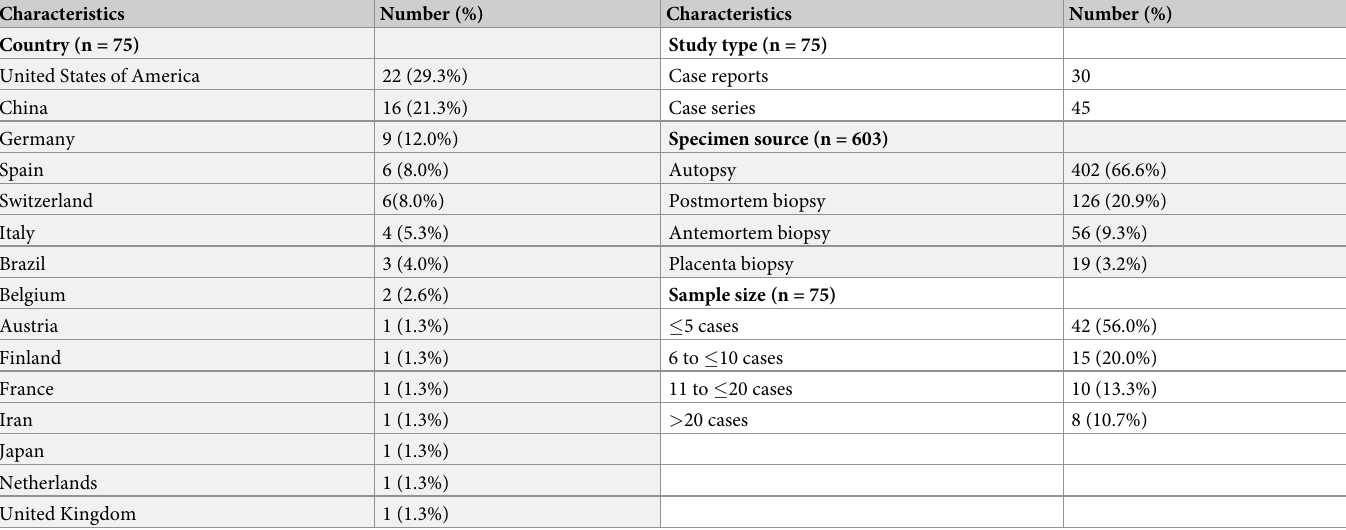
Table 1. Study characteristics.